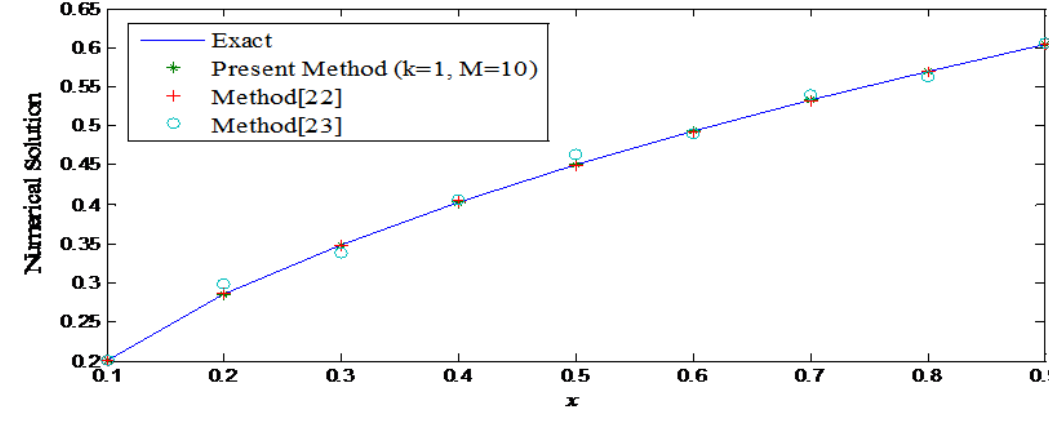
Fig. 2 Comparison of numerical solutions, exact solutions and existing methods of example